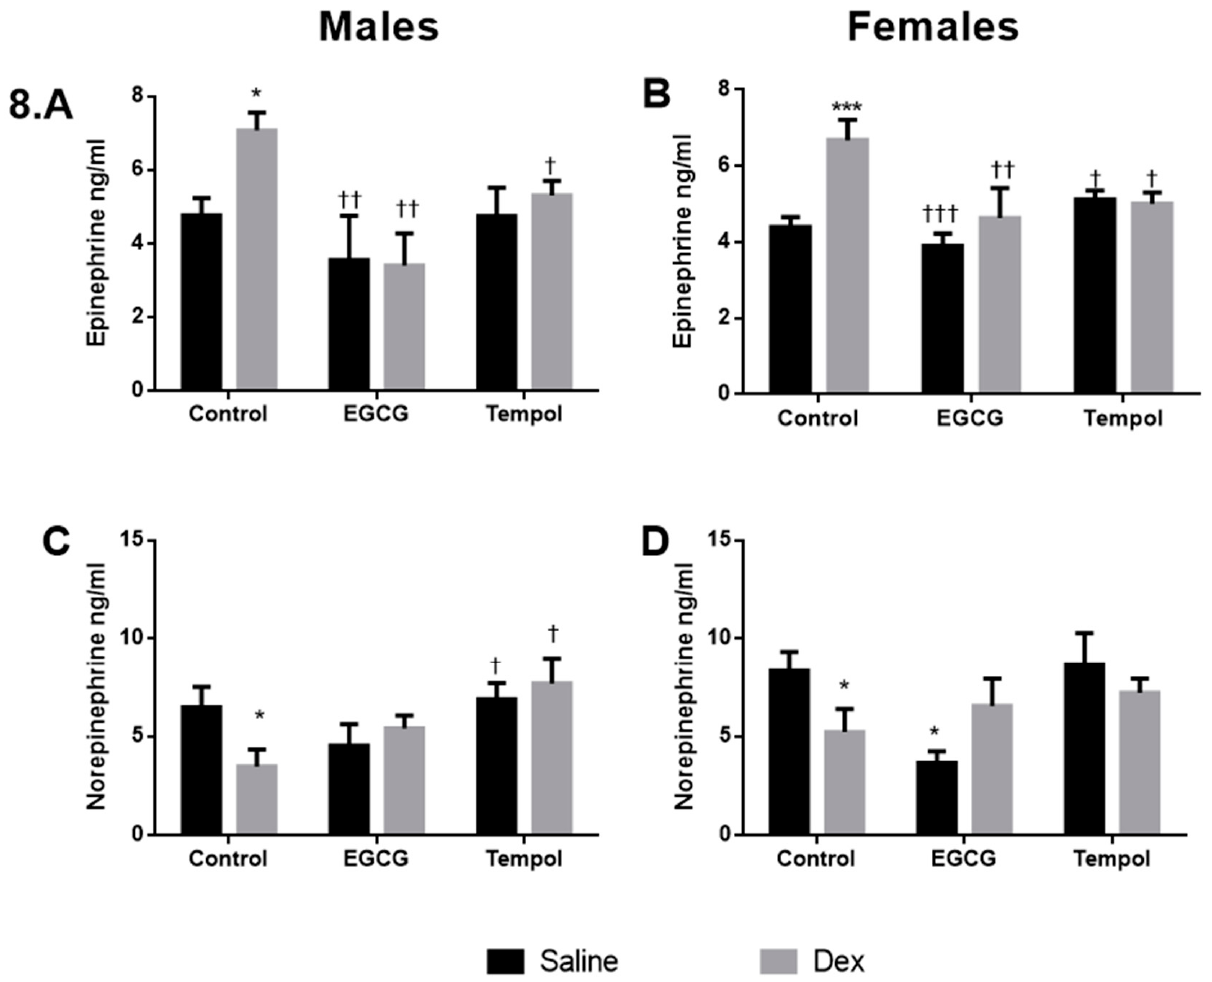
Figure 8. Plasma Catecholamine levels. Results from plasma catecholamine ELISA for epinephrine ( A , B ) and norepinephrine ( C , D ) for males and females, respectively. Saline and Dex control have been published previously and have been provided for reference Statistical analysis was performed using a two-way ANOVA (Fisher’s LSD test) shown as */† p ≤ 0.05, †† p ≤ 0.01, ***/††† p ≤ 0.001. Data are presented as mean ± SEM. Comparison to the Control-Saline group is represented with the symbol (*) and (†) for the Control-Dex offspring n = 4–6 per group. Significant interactions between maternal injection and antioxidant administration were found for epinephrine females.